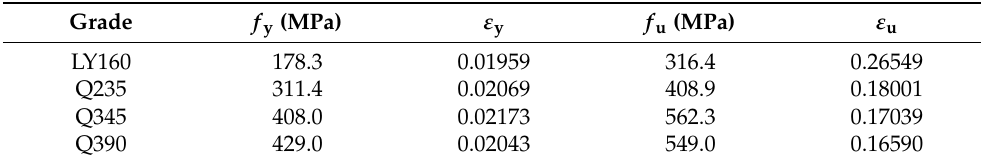
Table 4. Mechanical properties of steel